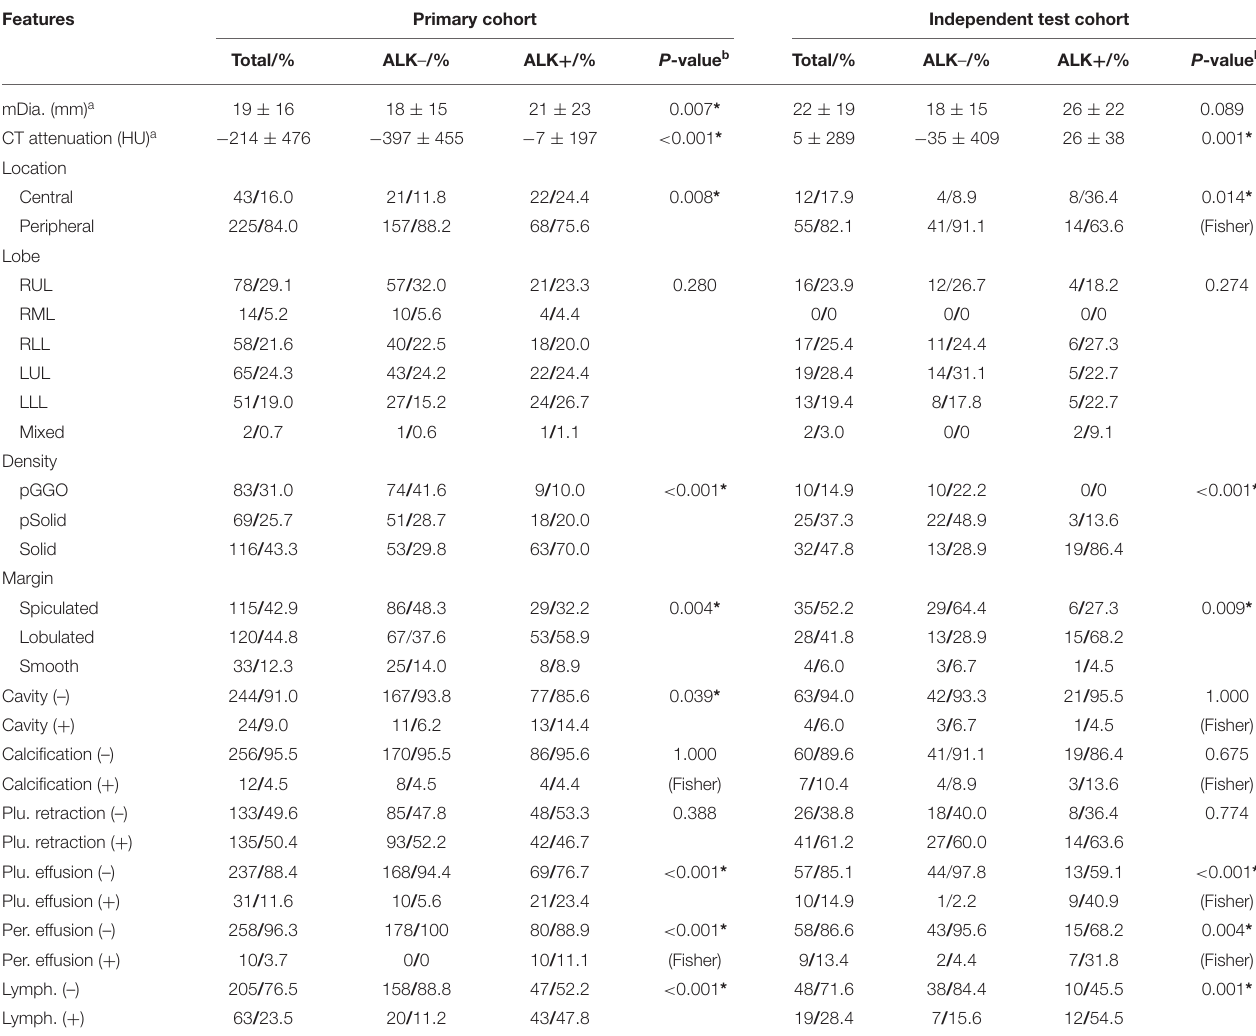
TABLE 2 | Conventional CT features of ALK– and ALK + lung adenocarcinoma patients in the primary and test cohort.